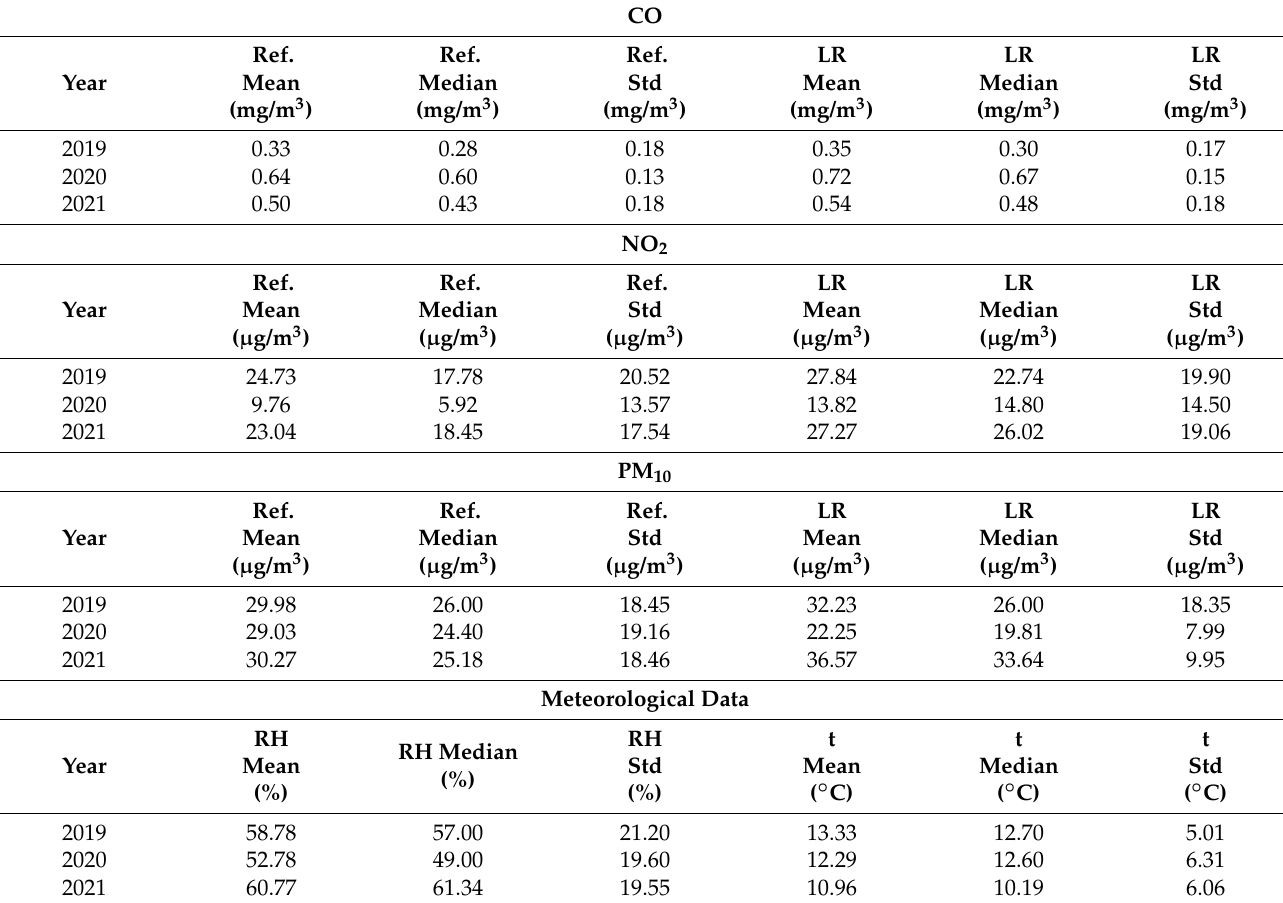
Table 3. Mean, median and standard deviation values for the measured